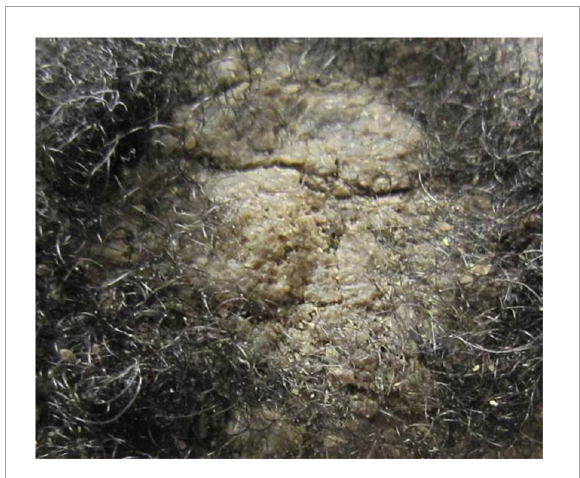
FIGURE1 Mounded and refractory keratoses, an atypical presentation of pemphigus vulgaris affecting the scalp. Presentations can include brown–gray mounded scales with or without the crust.